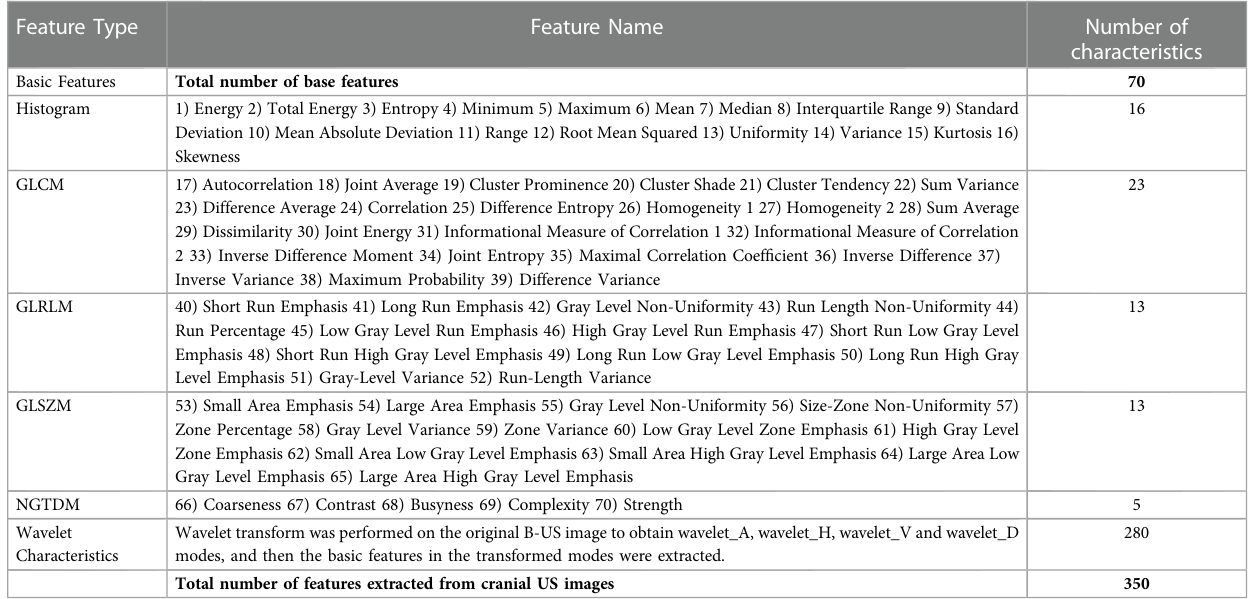
TABLE 1 350 features extracted from